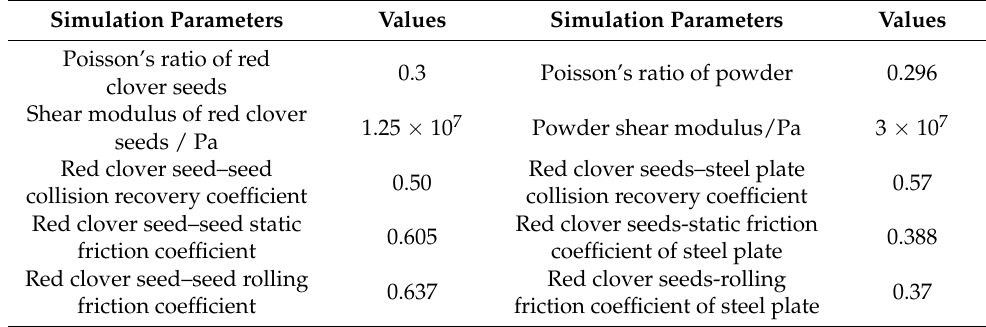
Table 3. Discrete element simulation test